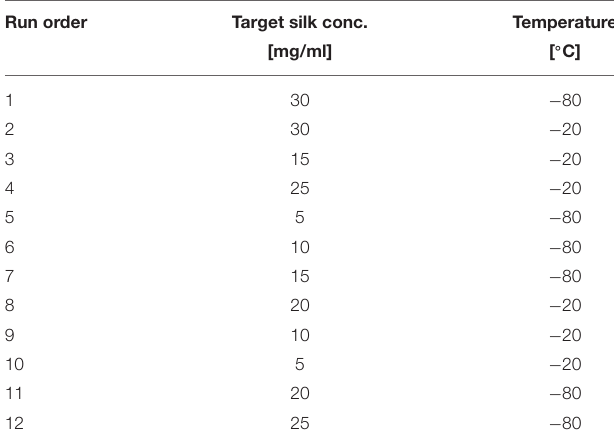
TABLE 1 | Factorial design for the scaffold preparation. Run